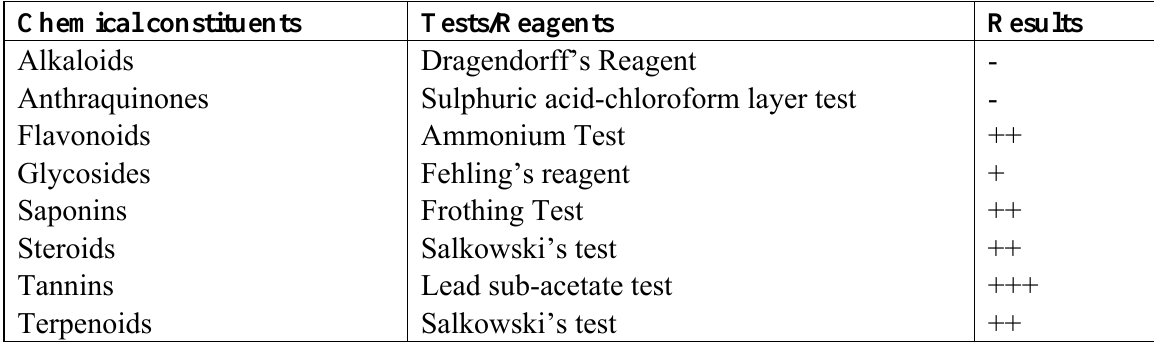
Table 3. Phytochemical profile of the methanolic extract of Languas galanga